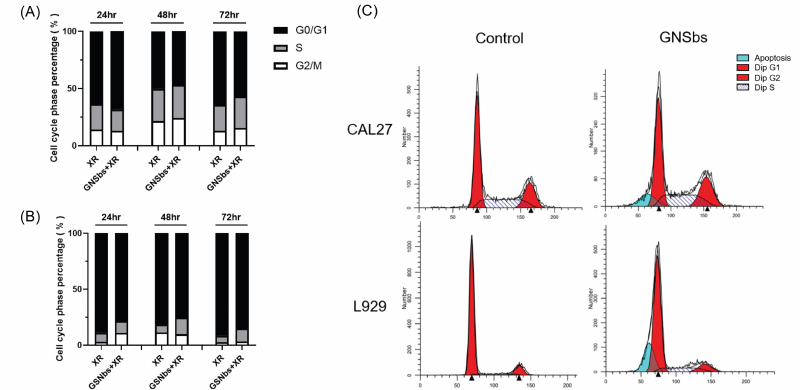
Figure 7. Cell cycle of CAL-27 and L929 treated with 2 Gy XR and GNSbs. The cell cycle phase of ( A )